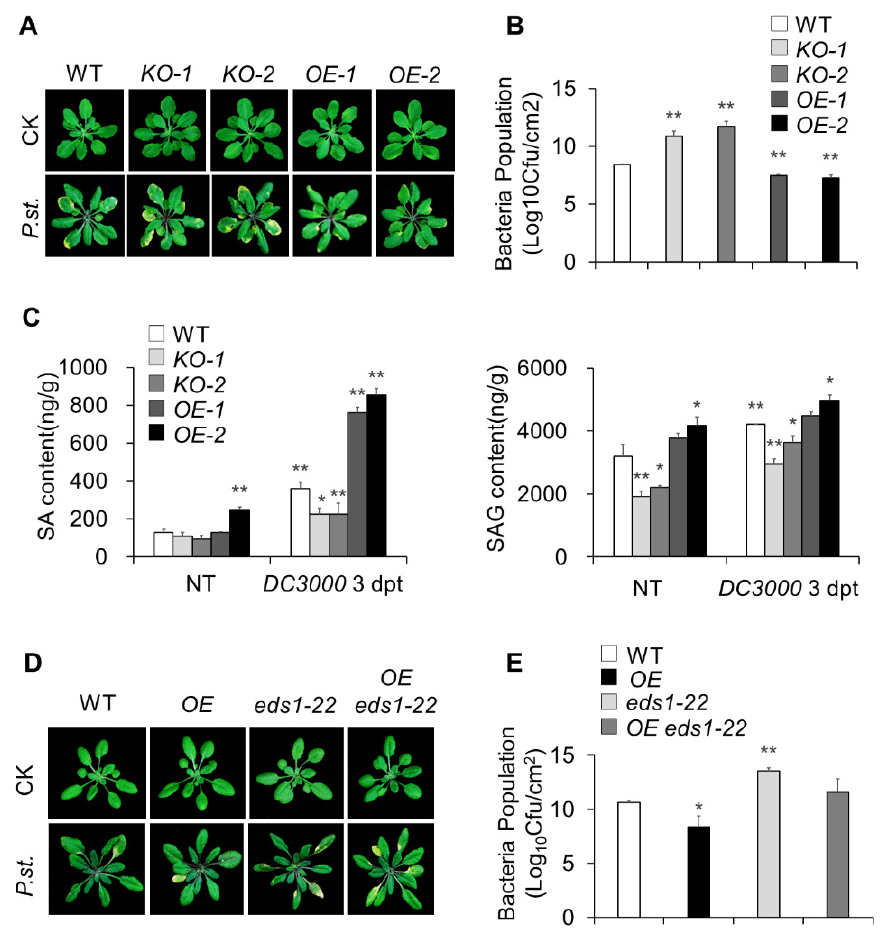
Figure 3. MACP2-strengthened plant resistance relying on SA pathway to the bacterial pathogen. ( A ) Phenotypes of wild-type, MACP2-KOs , and MACP2-OEs in response to Pst DC3000 infection. Four-week-old wild-type, MACP2-KOs , and MACP2-OEs were infected with Pst DC3000 on leaf surface and photographed 5 days after treatment. ( B ) Bacterial populations at 5 days postinoculation in wild-type, MACP2-KOs , and MACP2-OEs leaves. The data represent means from three independent repeats. Statistical differences were identified using Student’s t test. ** p < 0.01. ( C ) SA contents detection of wild-type, MACP2-KO mutants, and MACP2-OEs adult plants during Pst DC3000 infection. The contents of SA and SAG were measured by LC-MS. The “g” in “ng/g” represents the fresh weight. The experiments were biologically repeated three times with similar results. Error bars represent SD ( n = 3 biological replicates). * p < 0.05, ** p < 0.01 by Student’s t test. ( D ) Phenotypes of leaves from 4-week-old wild-type, MACP2-OE, eds1-22, and MACP2-OE eds1-22 leaves in response to Pst DC3000 infection. ( E ) Bacterial populations at 5 days postinoculation in wild-type, MACP2-OE, eds1-22, and MACP2-OE eds1-22 leaves. The data represent means from three independent repeats. Statistically significant differences were identified using Student’s t test. * p < 0.05, ** p <